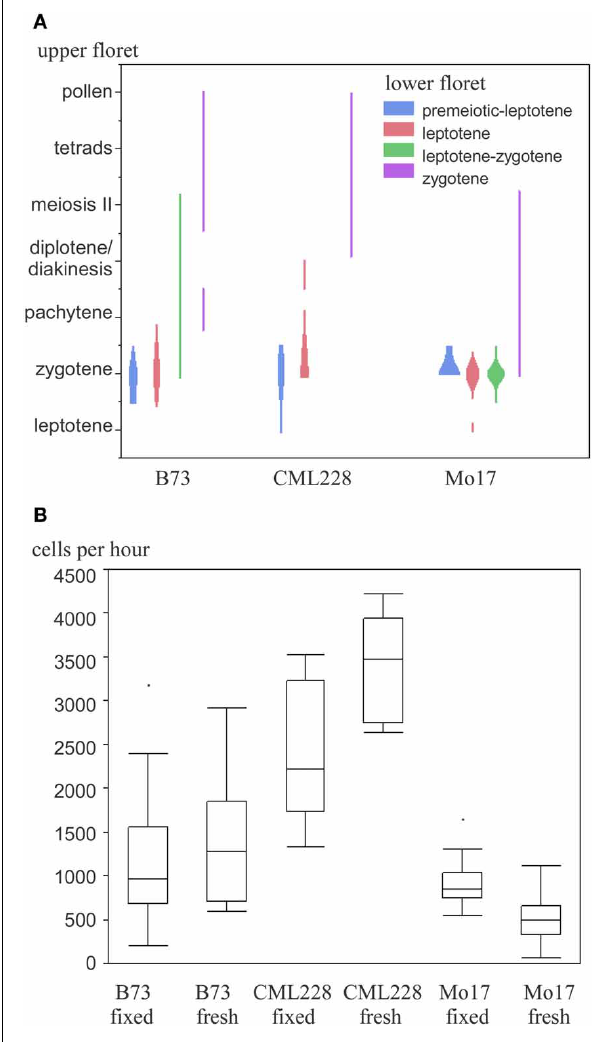
FIGURE 4 | Maize meiotic stages and meiocyte collection efficiency of different inbred lines. (A) Occurrence of paired meiotic stages in upper and lower florets. (B) Collection efficiency in fixed and fresh material.